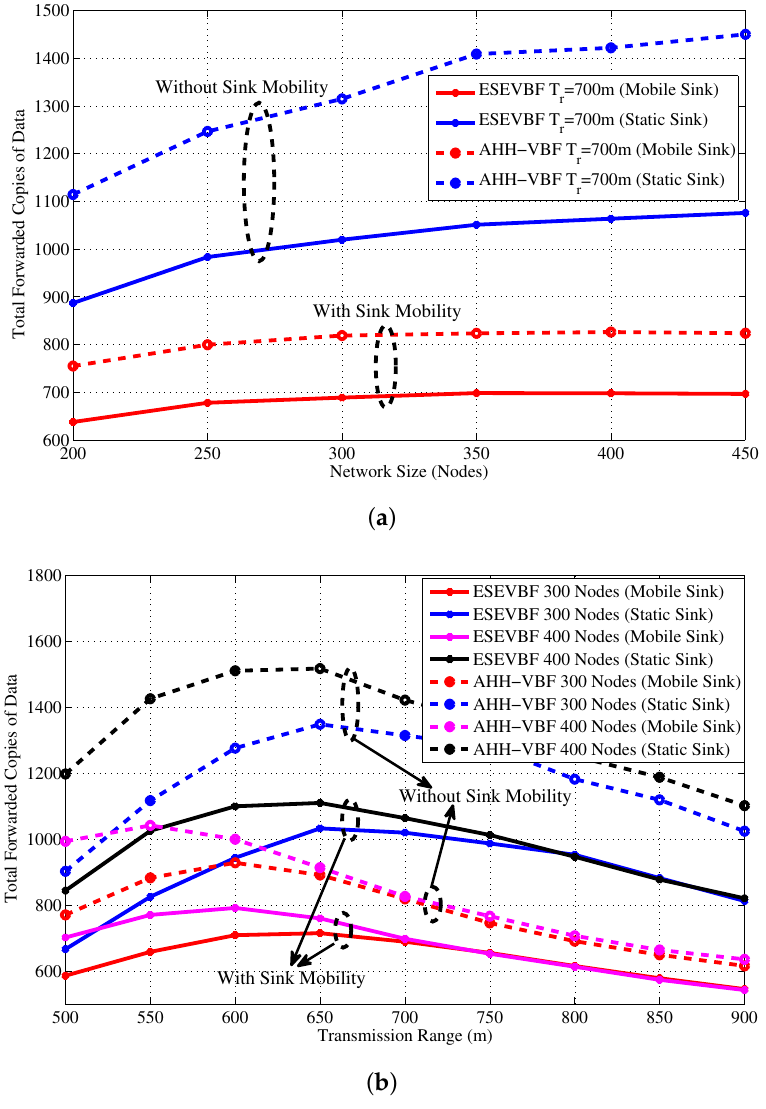
Figure 19. Total copies of data message forwarded in the network with and without Sink mobilty for different ( a ) network size ( b ) transmission